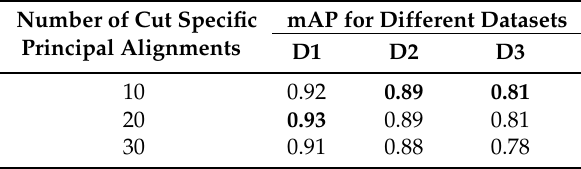
Table 8. Retrieval performance on the 3 datasets D1, D2 and D3 for varying number of cut specific principal alignments.